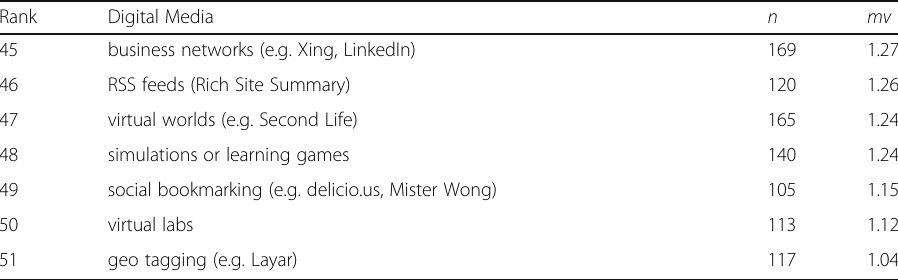
Table 3 Ranking by mean - ‘ How often do you use these digital media tools for studying? ’